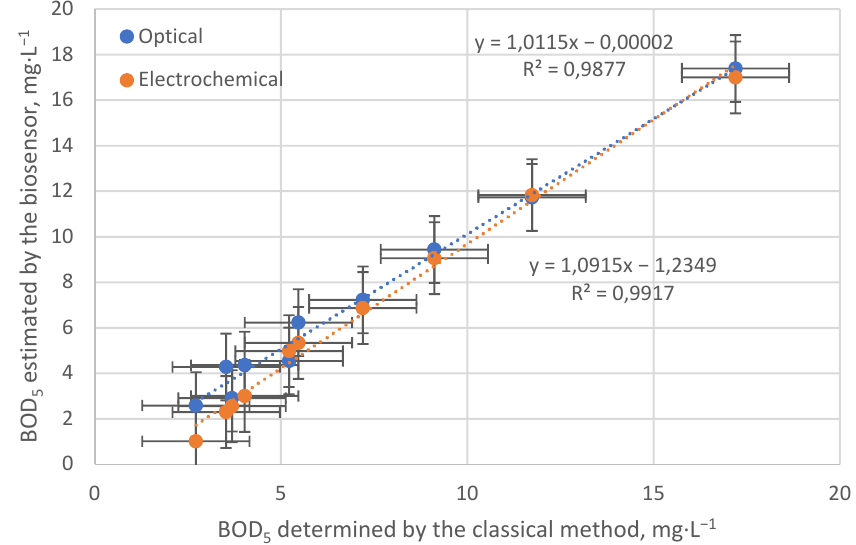
Figure 8. Dependence of the estimated BOD 5 parameter on that determined by the classical method.